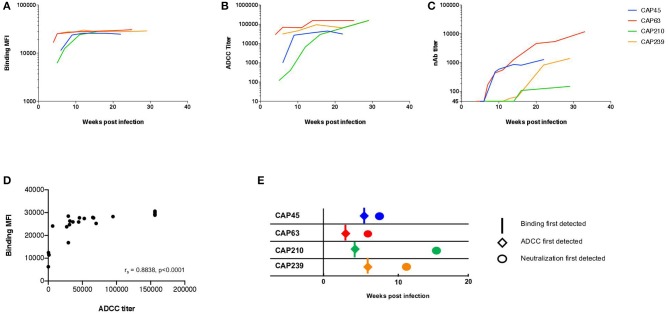
The kinetics of binding, ADCC, and nAb responses to HIV-1 subtype C in four participants of the CAPRISA 002 cohort. Binding (mean fluorescent intensity (MFI) at 1:50 dilution shown) of (A) and ADCC activity (titer, starting at 1:100 dilution) against (B) recombinant 1086cΔ7 gp120-coated CEM.NKRCCR5 cells, and the nAb responses against pseudoviruses with the T/F Envelope incorporated (ID50 titer, starting at a 1:45 dilution) (C) was determined longitudinally for four participants: CAP45 (blue), CAP63 (red), CAP210 (green) and CAP239 (orange). Binding MFI (at 1:50 dilution) and ADCC titer were plotted and a Spearman's r was calculated (rs = 0.8838 (95% CI: 0.7359–0.9512), p < 0.0001) (D). The time of first detection was determined for binding (vertical lines), ADCC (diamonds) and nAb (circles) responses (E).